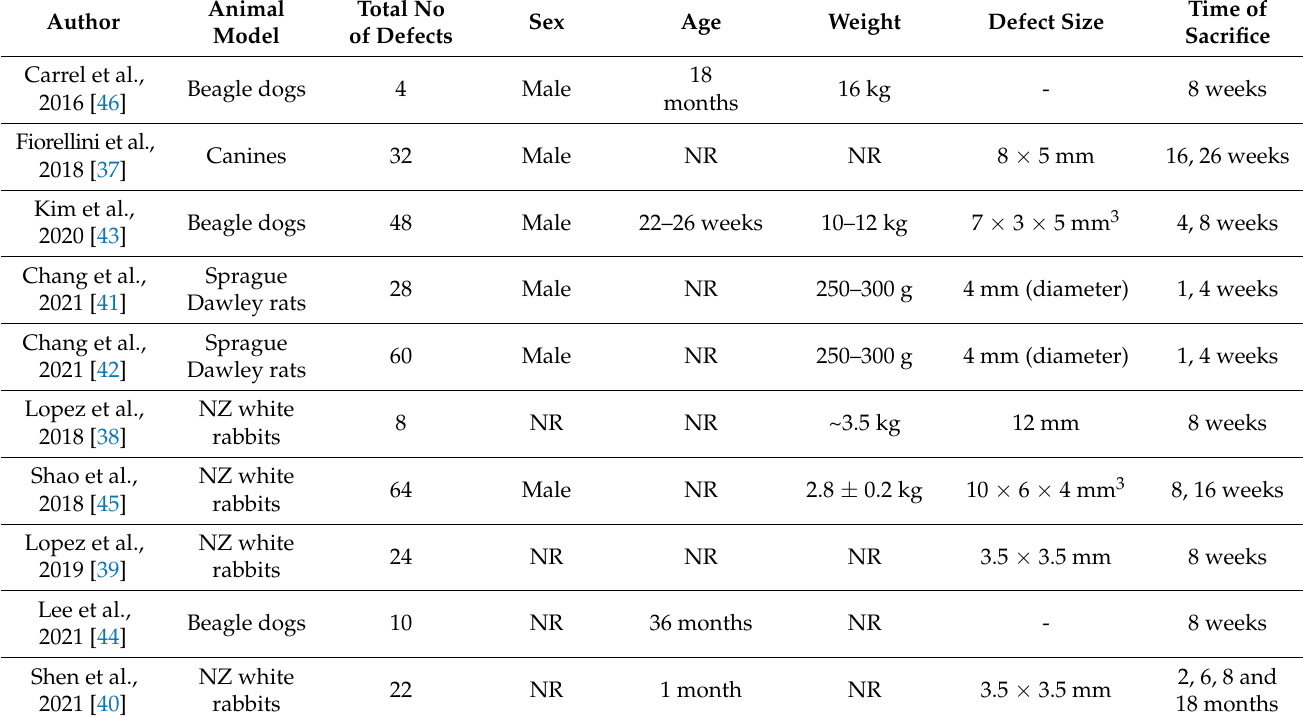
Table 3. Summary of animal model